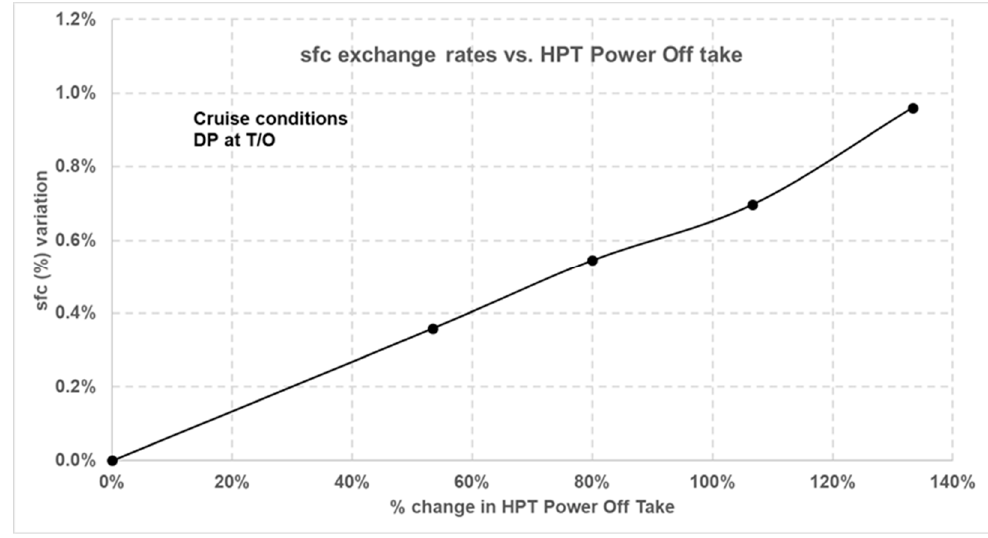
Figure 19. SFC exchange rates vs. HPT power offtake.